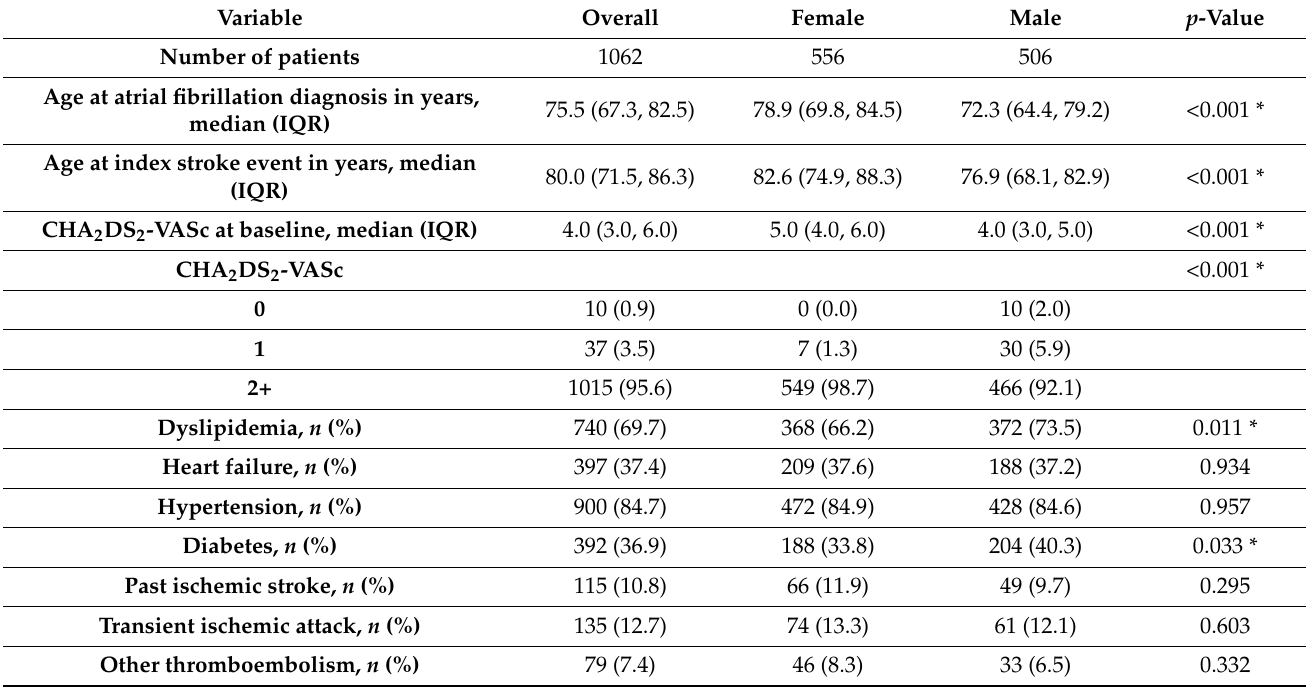
Table 1. Male and female ischemic stroke patient characteristics with a diagnosis of atrial fibrillation before index stroke